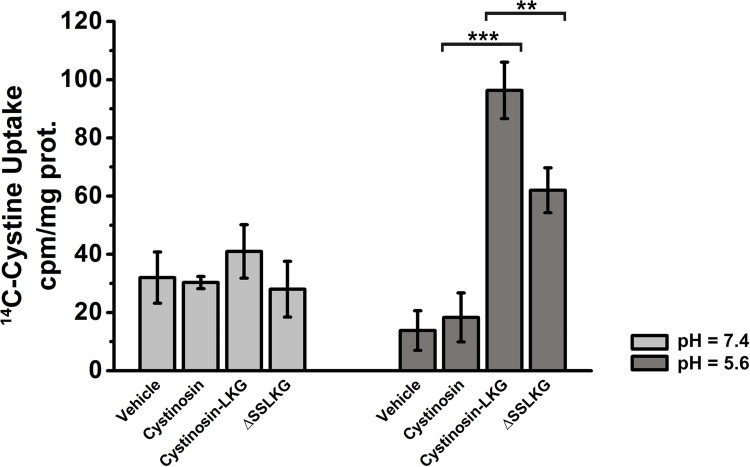
14C-cystine uptake from extracellular milieu in HK-2 transfected with different cystinosin isoforms.14C-cystine uptake assay performed in HK-2 cells transfected with vehicle, cystinosin, cystinosin-LKG, or ΔSSLKG mutant, shows low uptake of radiolabelled L-[14C]-cystine across plasma membrane in absence of a proton gradient (light grey columns). In the presence of a proton gradient (dark grey columns) HK-2 cells overexpressing cystinosin-LKG show a significant 14C-cystine uptake (p < 0.0005) compared to cells transfected with cystinosin; while HK-2 cells overexpressing ΔSSLKG mutant show lower 14C-cystine uptake (p < 0.004) compared to cells transfected with cystinosin-LKG. Means ± SEM of three experiments are shown.